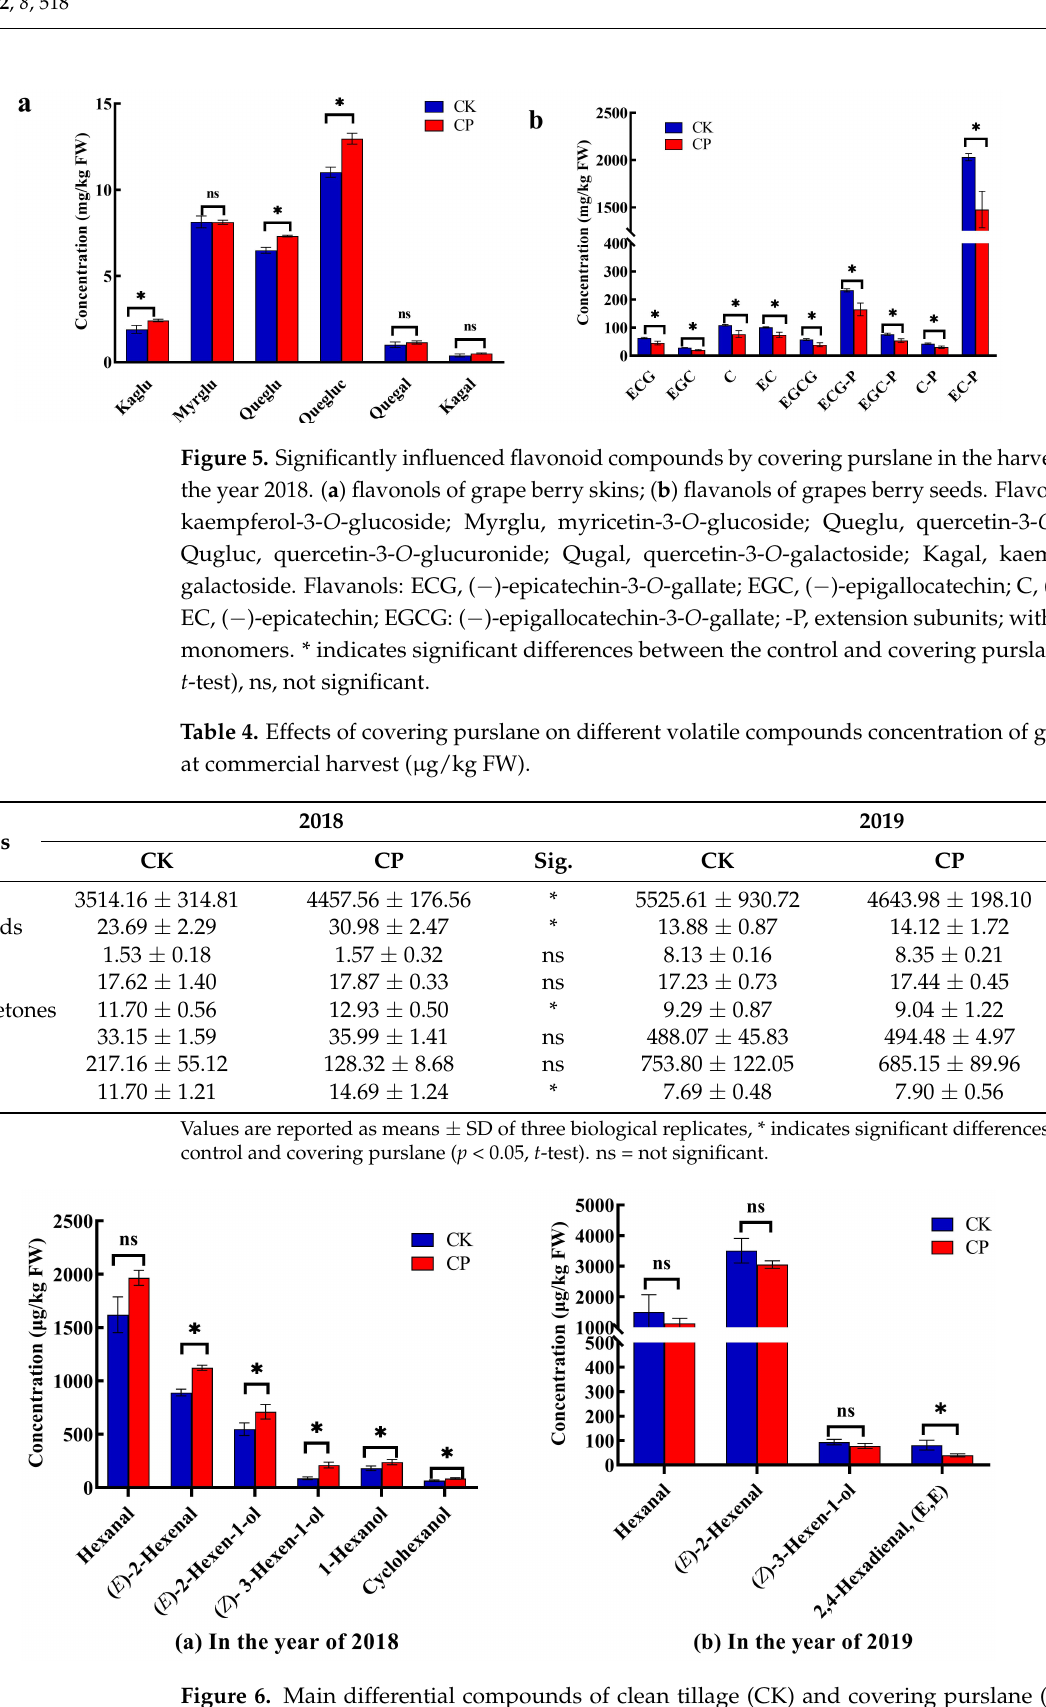
Figure 6. Main differential compounds of clean tillage (CK) and covering purslane (CP) berries. * indicates significant differences between the control and covering purslane ( p < 0.05, t -test), ns, not significant.